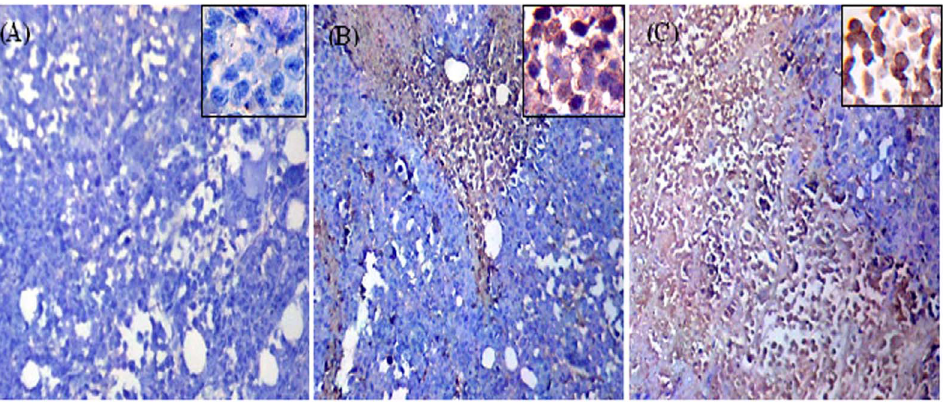
Figure 9. Photomicrographs represent immunohistochemistry staining of p53 expression of ESC sections from mice. A ) Shows negative staining for p53 in ESC from untreated mice. B ) Shows moderate expression of p53 ( ++ ) in ESC from mice received IP MNPs. C ) shows overexpression of p53 ( +++ ) in ESC from mice received IT MNPs. Magnification is 10X. Also higher magnified photo is shown for each group (40X).